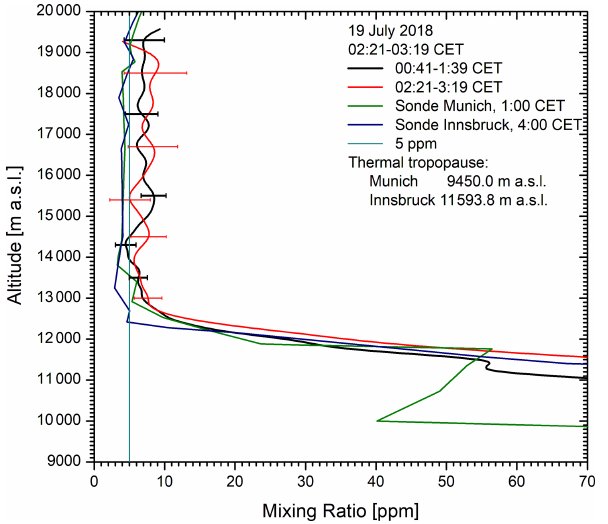
Figure 14. Nitrogen and water-vapour backscatter signals on 5 February 2019 as a function of the vertical distance above UFS; The H 2 O backscatter profiles averaged over 151 7.5m bins (i.e. raw data; VDI vertical resolution: 562.5m) become noisy at about 17km (19.7kma . s . l . ). The laser pulse energy was just 360mJ